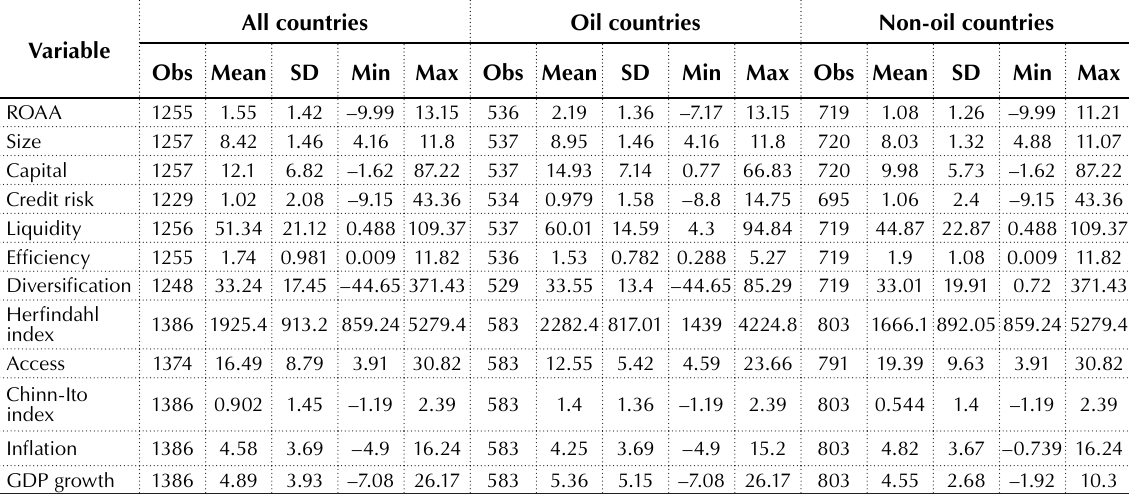
Table 2. Descriptive statistics by country category